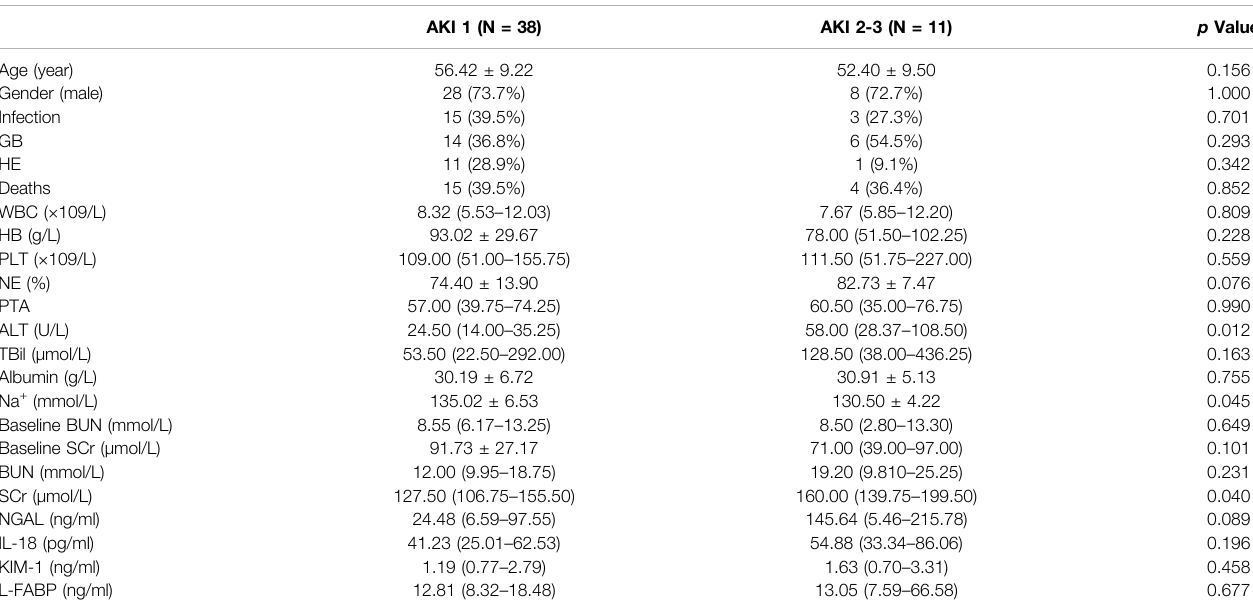
TABLE 4 | Characteristics of patients with cirrhosis at different AKI